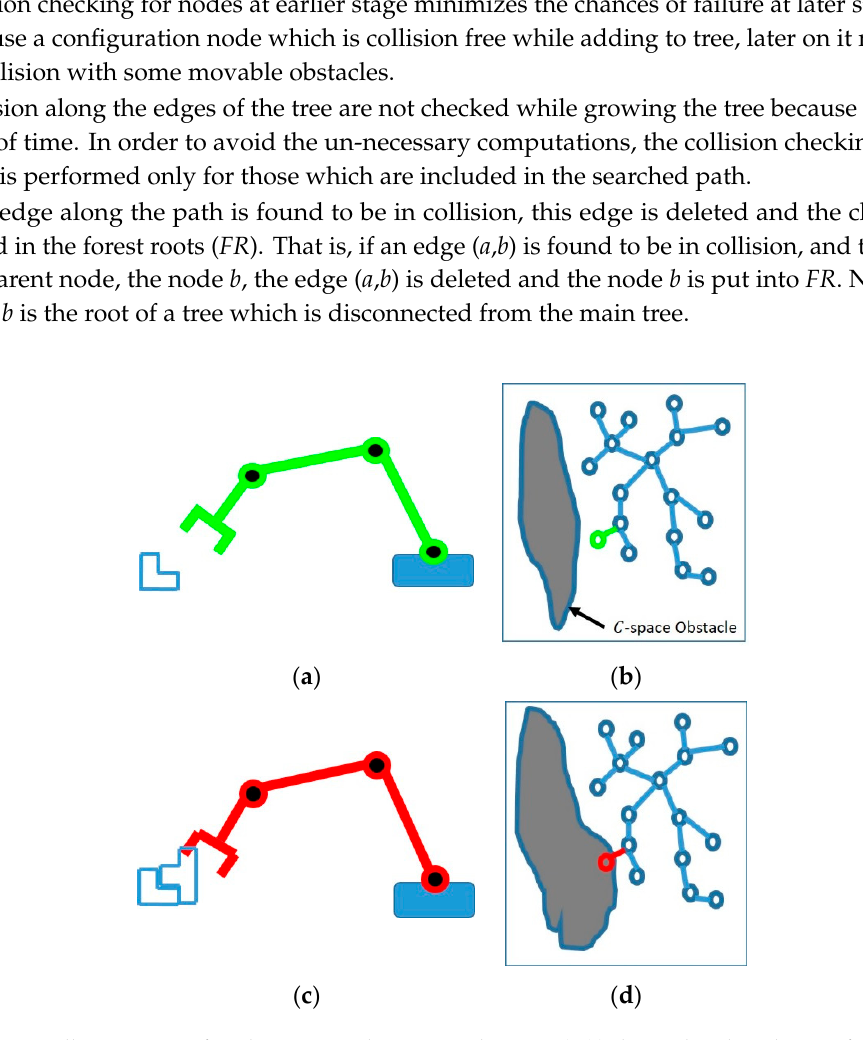
Figure 5. Collision status of a robot state in changing task space. ( a , b ) shows that the robot configuration is collision free in initial state of task space. ( c , d ) shows the robot state, which was collision free in initial stage of assembly task, is now in collision with environment due to change in task space. The failed nodes in FR are tried to be connected to the main tree while extending the tree. The two stage extend tree is presented in the next